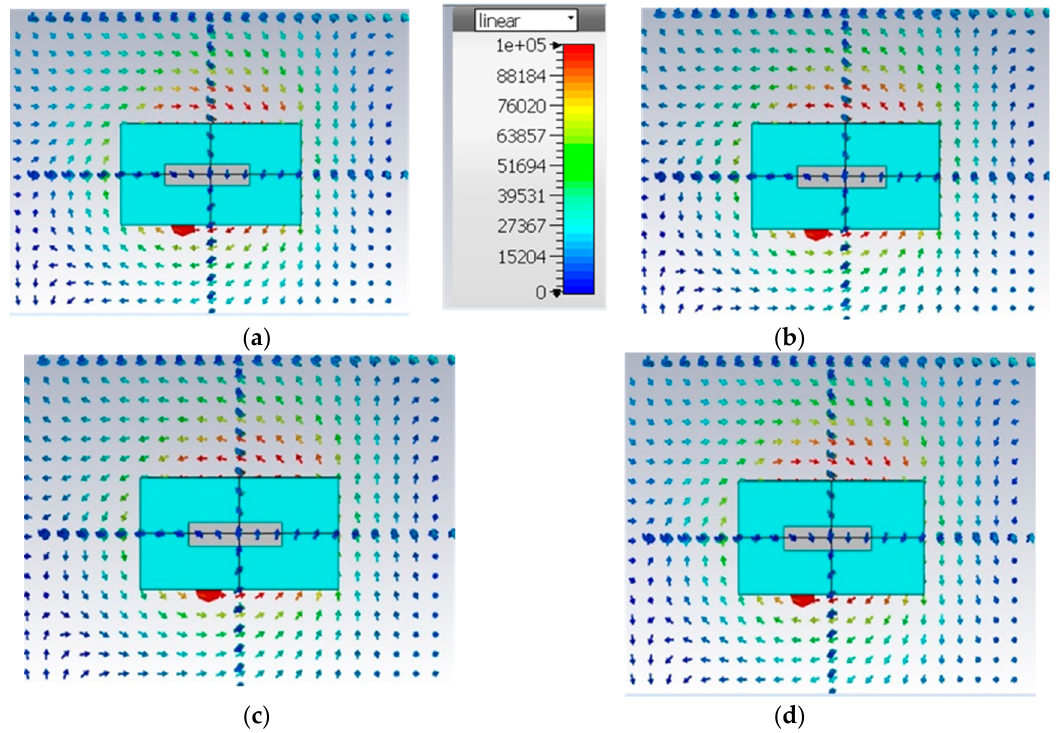
Figure 8. Electric field distribution inside the proposed design ( a ), Phase 00, ( b ), Phase 90° ( c ), Phase 180° ( d ) Phase 270°(by using Eigen mode analysis in CST-MWS).